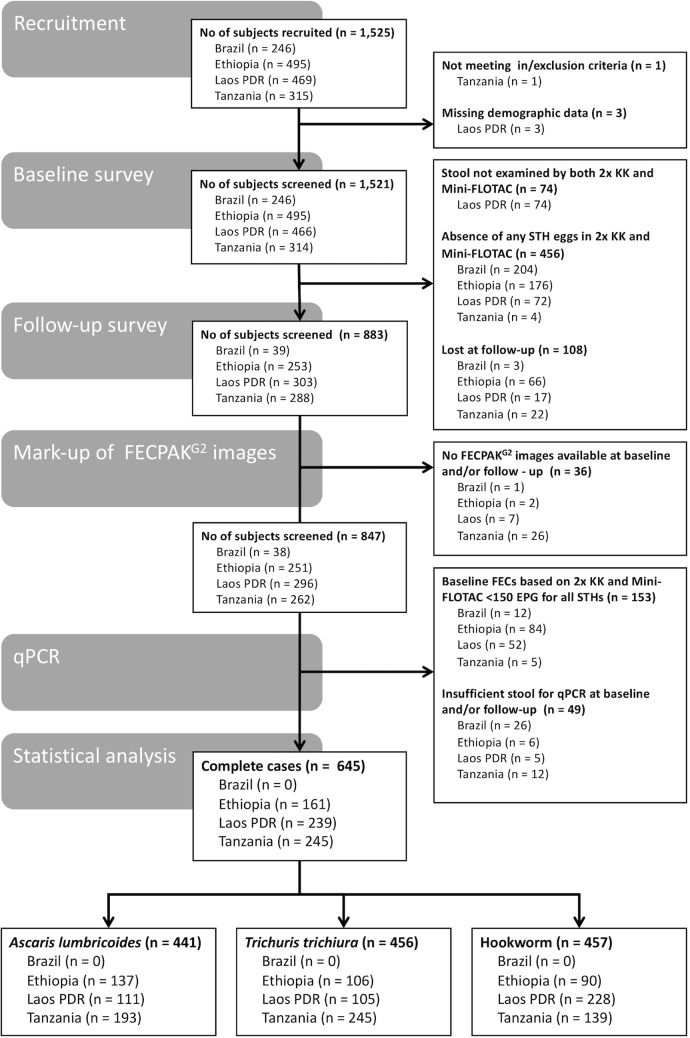
Number of subjects withheld at recruitment, baseline and follow-up, and for the statistical data analysis.STH: soil-transmitted helminth; n: number of subjects; FECs: fecal egg counts expressed in eggs per gram of stool (EPG), 2x KK: duplicate Kato-Katz.